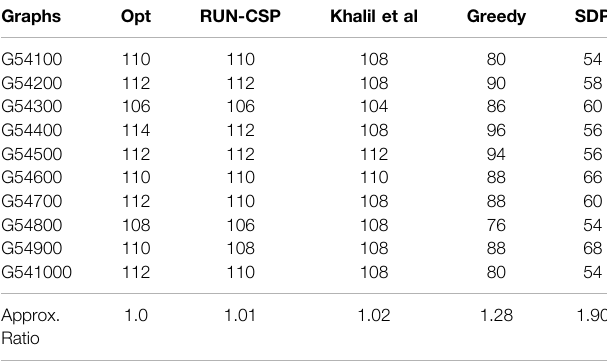
TABLE 3 | M AX -C UT : Achieved cut sizes on Gset instances for RUN-CSP, DSDP, and BLS. Graph